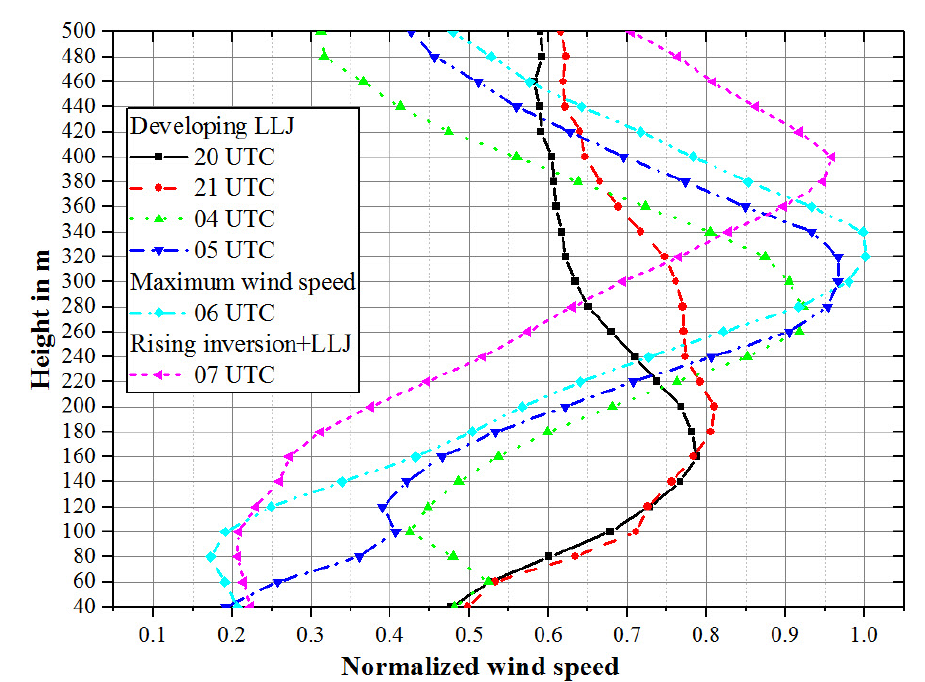
Figure 5. Vertical profiles of wind speed normalized by maximum value at the LLJ core (11.2ms − 1 ), measured by wind lidar during the night 18–19 June 2013.